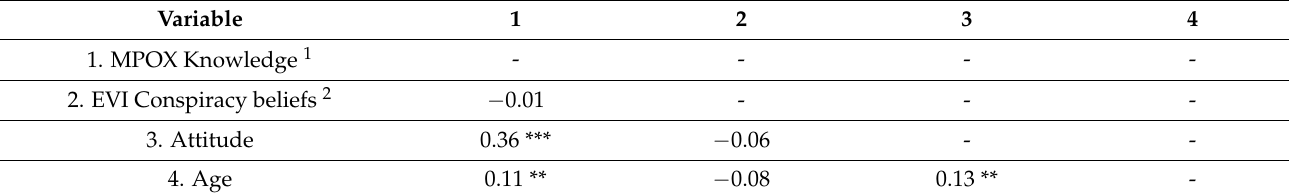
Table 6. Correlation of continuous variables between each